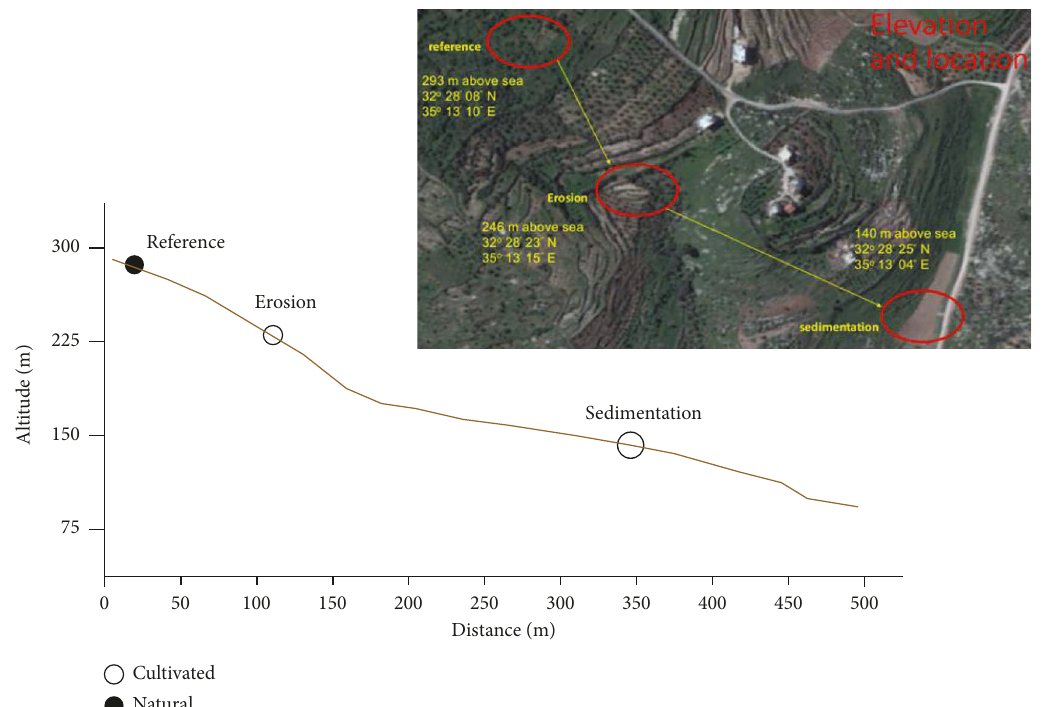
Figure 1: Location of the study area. The inset picture is an aerial view of the actual